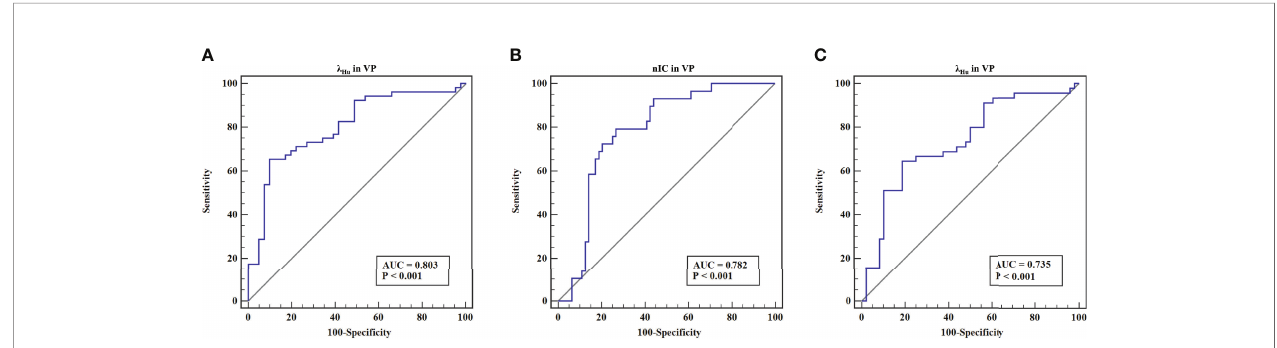
FIGURE 2 | The receiver operating characteristic curves of quantitative DECT parameters for discriminating the different aggressiveness of OTSCC. (A) The receiver operating characteristic curves of l Hu in VP for discriminating stage III-IV lesions from stage I-II lesions. (B) The receiver operating characteristic curves of nIC in VP for discriminating well-differentiated lesions (moderately or highly differentiated) from poorly differentiated lesions. (C) The receiver operating characteristic curves of l Hu in VP for discriminating lesions without lymph node metastasis from those with lymph node metastasis.